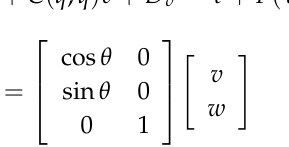
10 of 22 Figure 7. Rules for FGSO1 and FGSO1T2. 4. Autonomous Mobile Robot To test the proposed methodology with the dynamic adjustment of the parameters using the T1